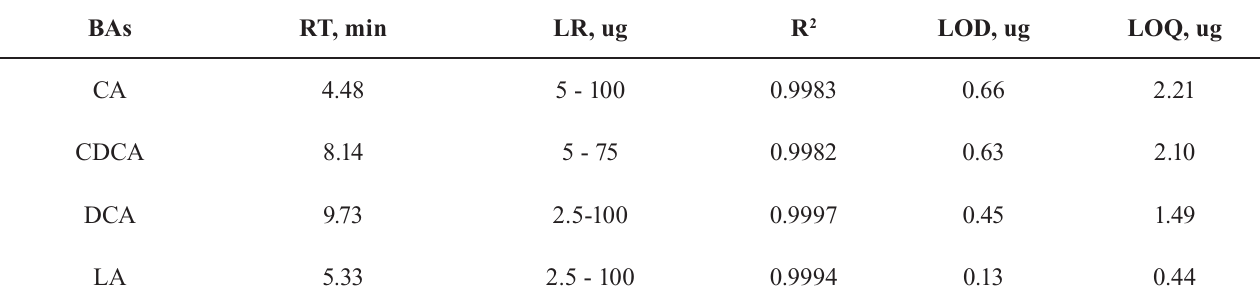
RT, retention time; LR, linear range; R2, correlation coefficient; LOD, limit of detection; LOQ, limit of